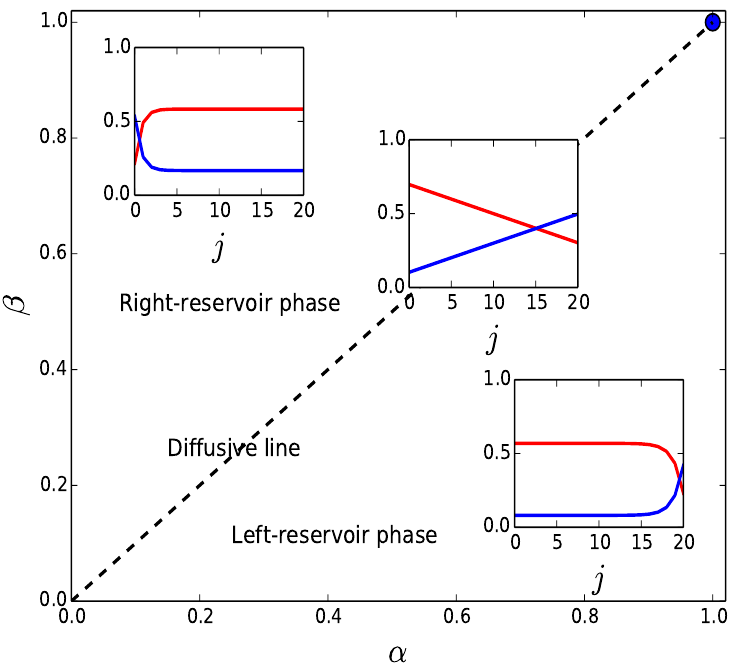
Figure 5: Phase diagram of the boundary driven cellular automaton. For the density plots in the insets we took a lattice of length L = 21, and depict density of + / − with red / blue curves The values of the parameters are α + = 0.7, α − = 0.1, β + = 0.1, β = 0.4 for the density plot in the left reservoir phase, α − β = 0.2 for the plot in the right reservoir phase and α − β = 0.5 for the plot on the diffusive line. The blue dot on the upper right of the − phase diagram represents an insulating point (no vacancies on the